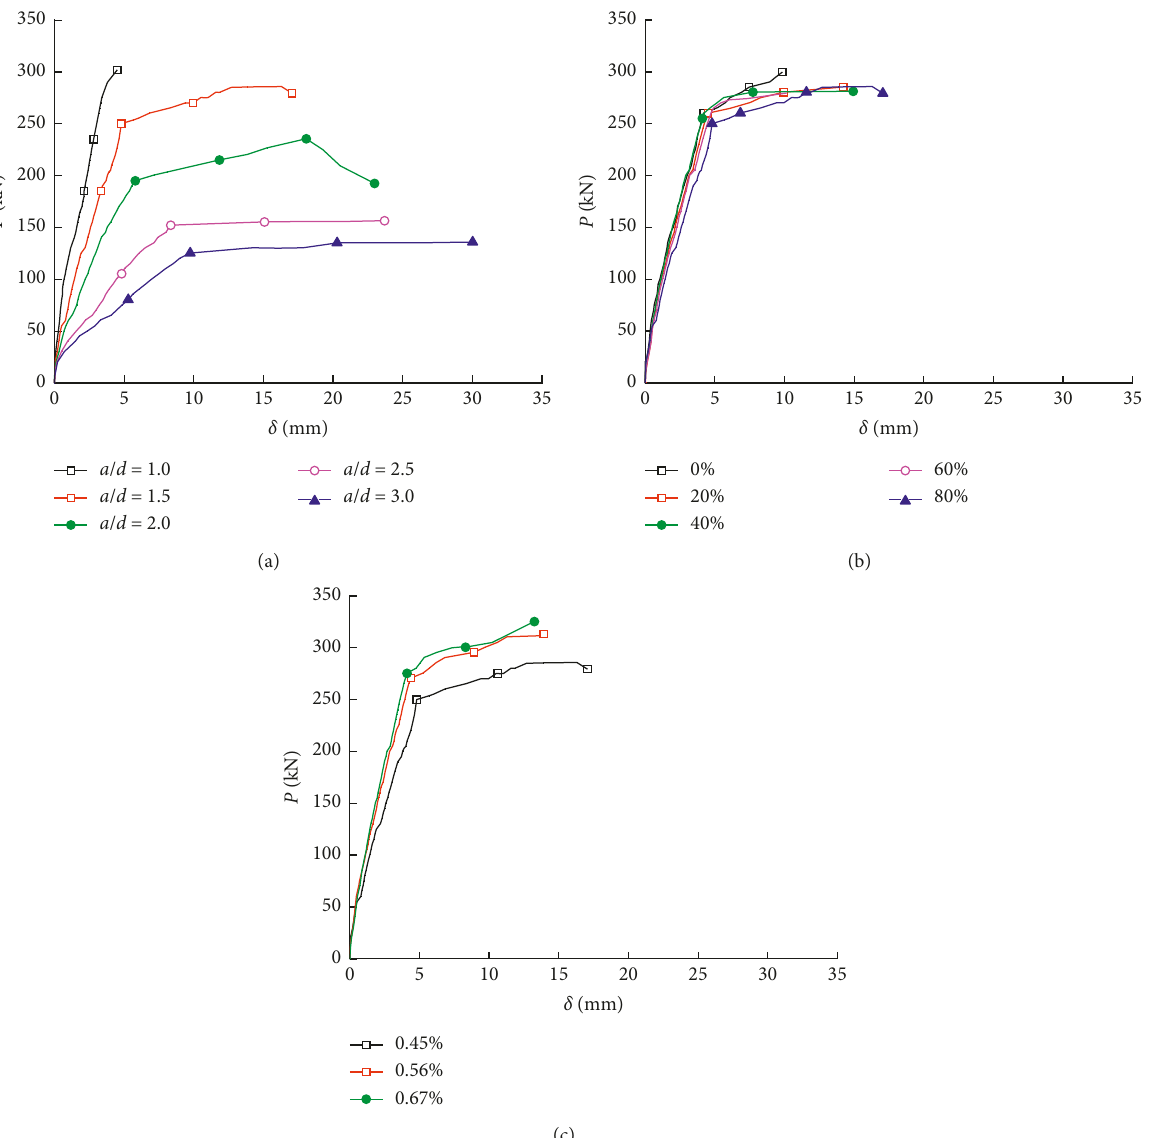
Figure 5: Load-deflection curves of beams: (a) series B1; (b) series B2; (c) series